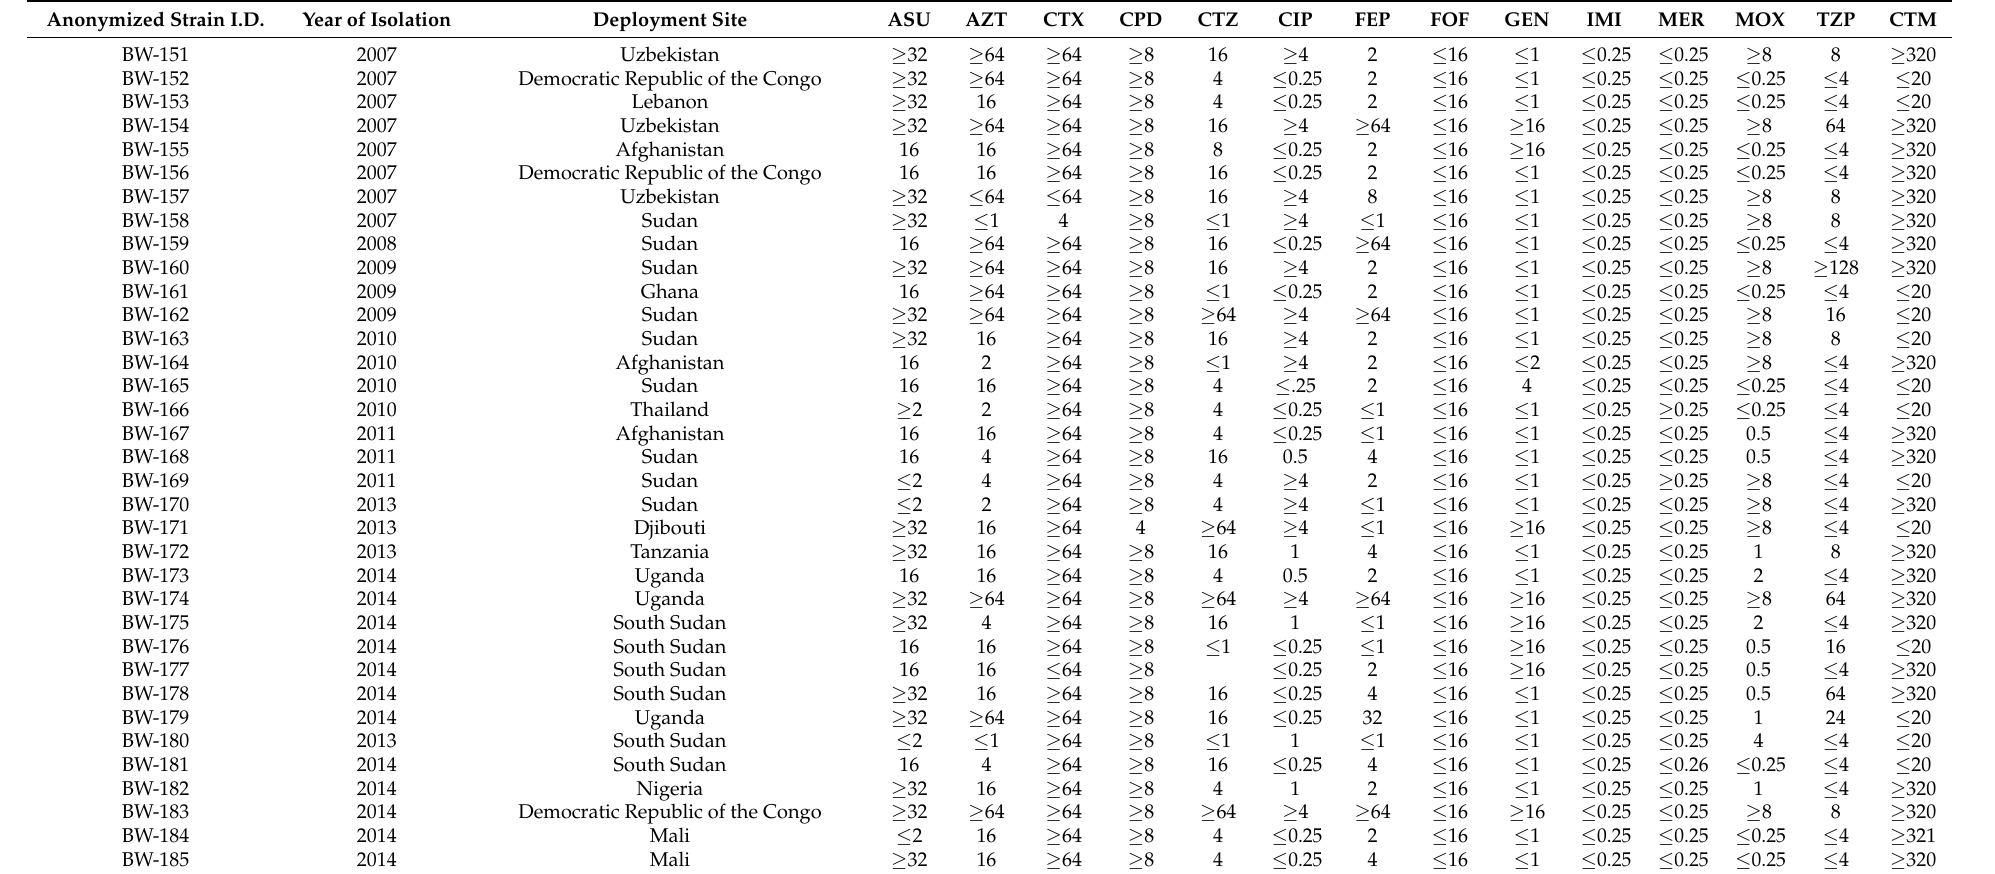
Table A1. Measured minimum inhibitory concentrations (MICs, mg/L) of the assessed ESBL-positive E. coli isolates. All isolates were resistant to ampicillin (each isolate MIC of ≥ 32 mg/L) and susceptible to ertapenem (each isolate MIC of ≤ 0.5